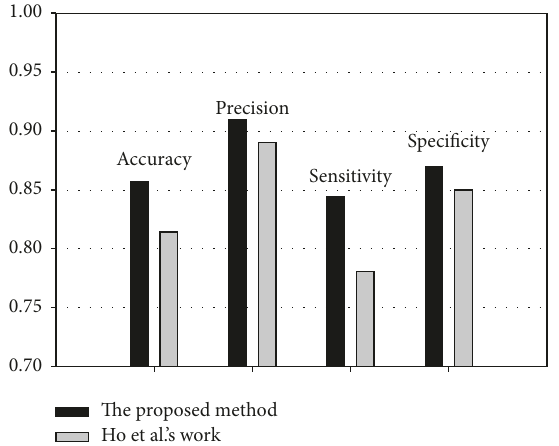
Figure 10: Comparison based on various confusion matrix metrics.